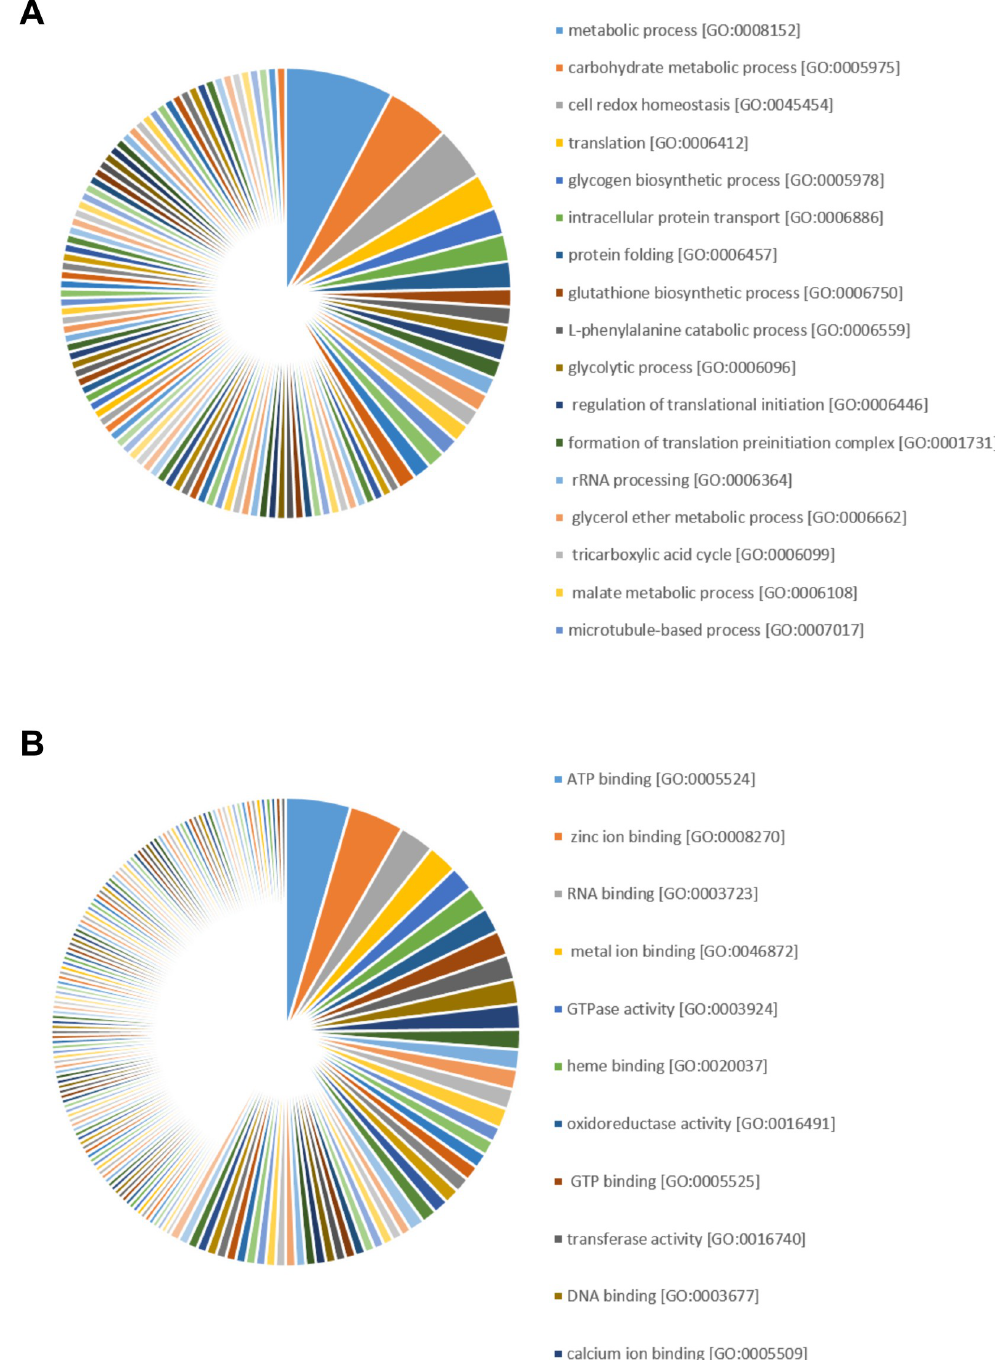
Fig 7. Gene ontology analysis of significantly regulated ( p < 0.05, ANOVA) proteins in livers of Atlantic salmon ( Salmo salar L.) exposed to graded levels of ethoxyquin (EQ) through their diet for 90 days. Proteins displaying differential expression ( p < 0.05, ANOVA) were grouped into the gene ontology categories biological processes (A) and molecular functions (B) . See S7 Table for a complete overview of individual proteins.